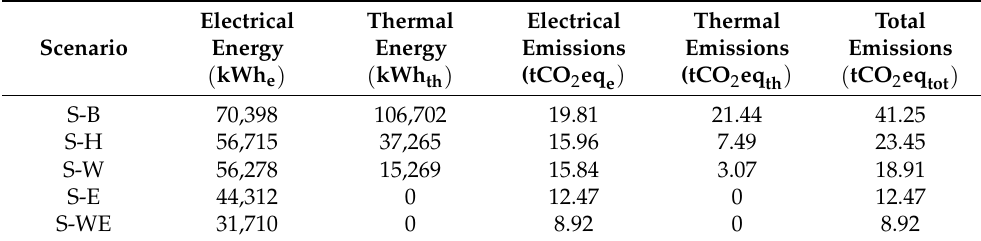
Table 9. Net imported energy and corresponding CO 2 eq